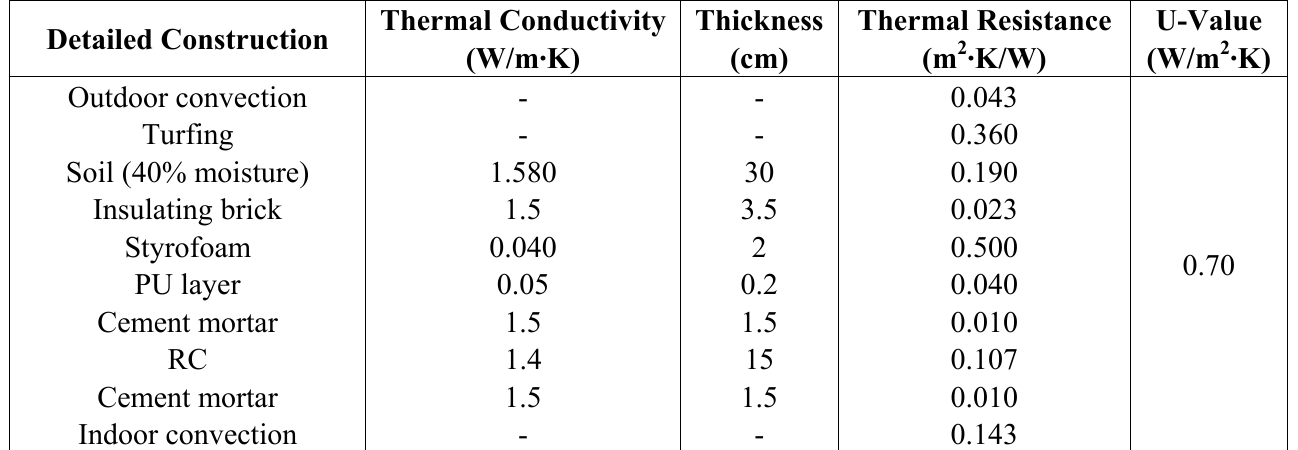
Table 6. Thermal properties of the green roof used in this